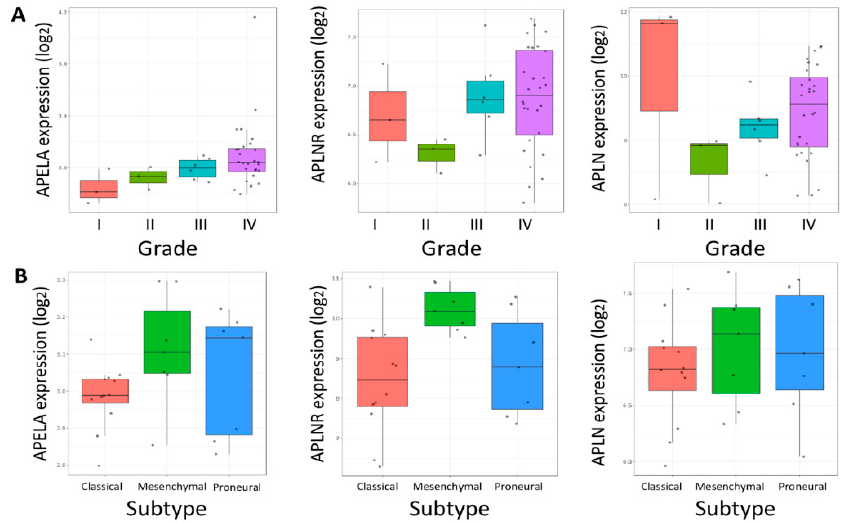
Figure 6. APELA expression as a function of glioma tumor grade and GBM molecular subtype. APELA, APLNR and APLN expression in the GSE43289 dataset plotted as a function of ( A ) histological grade in glioma or ( B ) molecular GBM subtype [20].